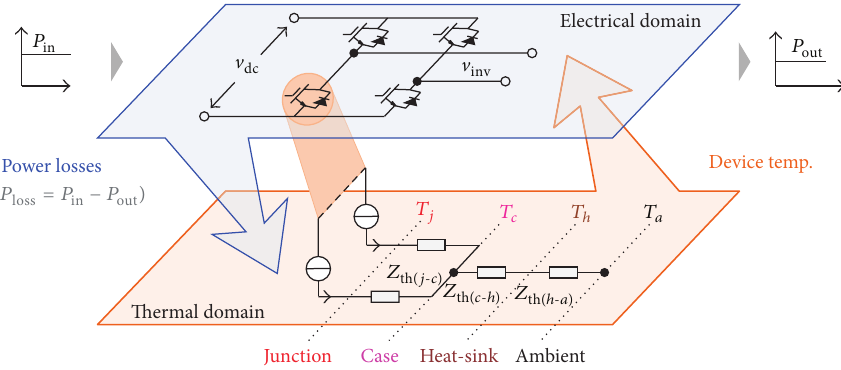
Figure 5: Coupled relationship between power losses and the junction temperature of the power switching devices. 𝑍 : case to heat-sink impedance, and 𝑍 impedance, 𝑍 th (𝑐 - ℎ)